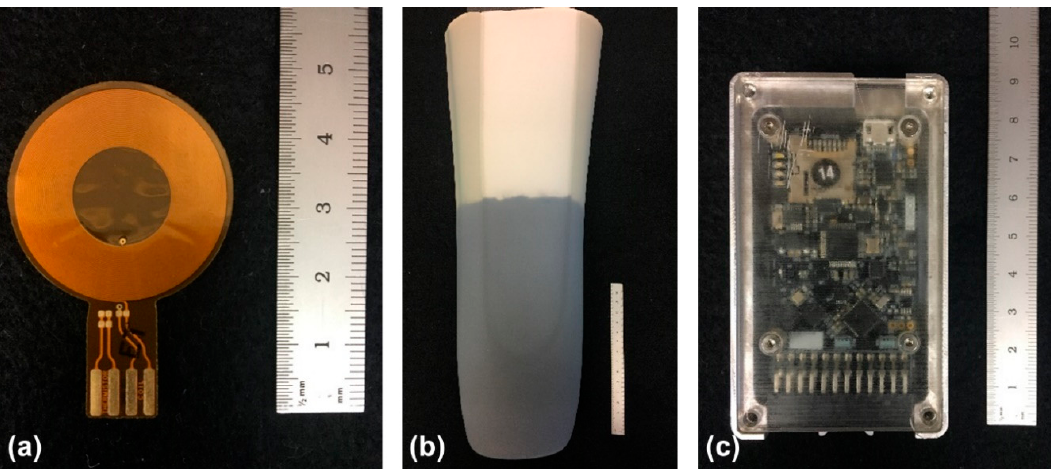
Figure 1. Inductive sensing system components: ( a ) sensor antenna; ( b ) inner surface of ferrous liner with iron-doped polymer between fabric and normal (unfilled) elastomer; ( c ) portable data acquisition unit.